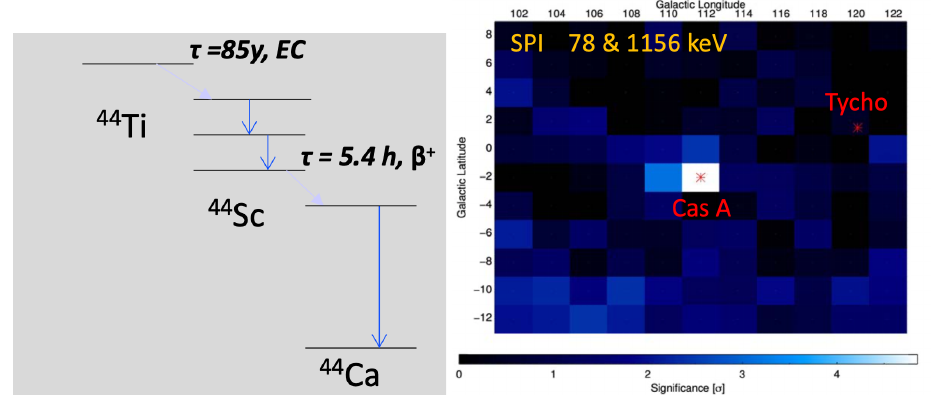
Figure 2. Left: The signal of 44 Ti decay results in lines at 68, 78, and 1156 keV. Right: The SPI 44 Ti line signal is clearly attributed to the Cas A source (right). [From